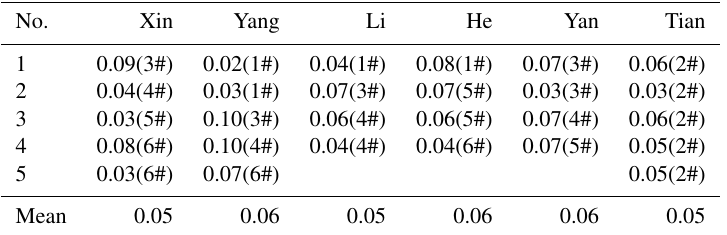
Table 2. The standard deviation of the declination baselines for each observer. The numbers in parentheses refer to the observation pillars in Fig. 1.